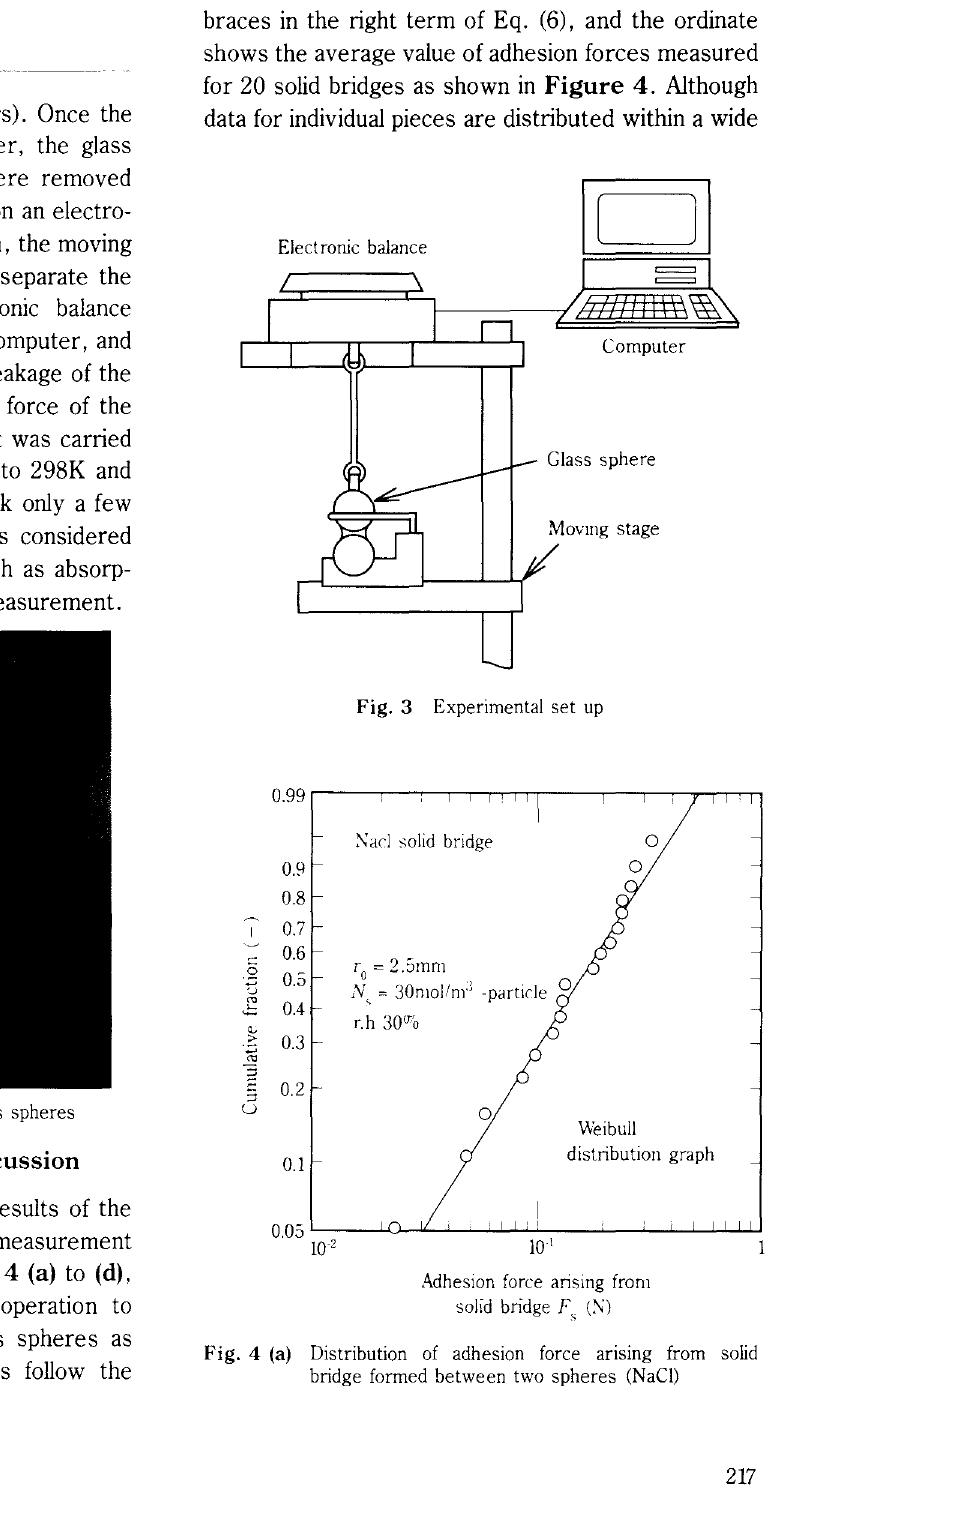
Fig. 2 Photograph of setting of two glass spheres 3.